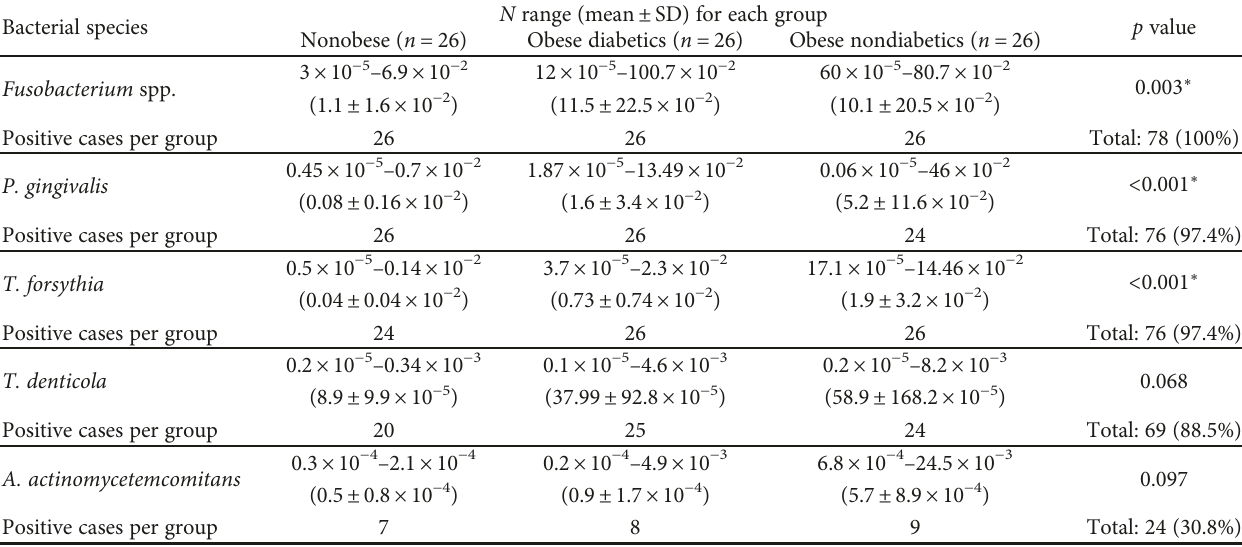
Table 3: Real-time PCR quanti fi cation of Fusobacterium spp., P. gingivalis , T. forsythia , T. denticola , and A. actinomycetemcomitans in the saliva of obese patients (diabetics and nondiabetics) compared to the nonobese nondiabetic control. N range (mean ± SD) for each group Bacterial species Fusobacterium spp.